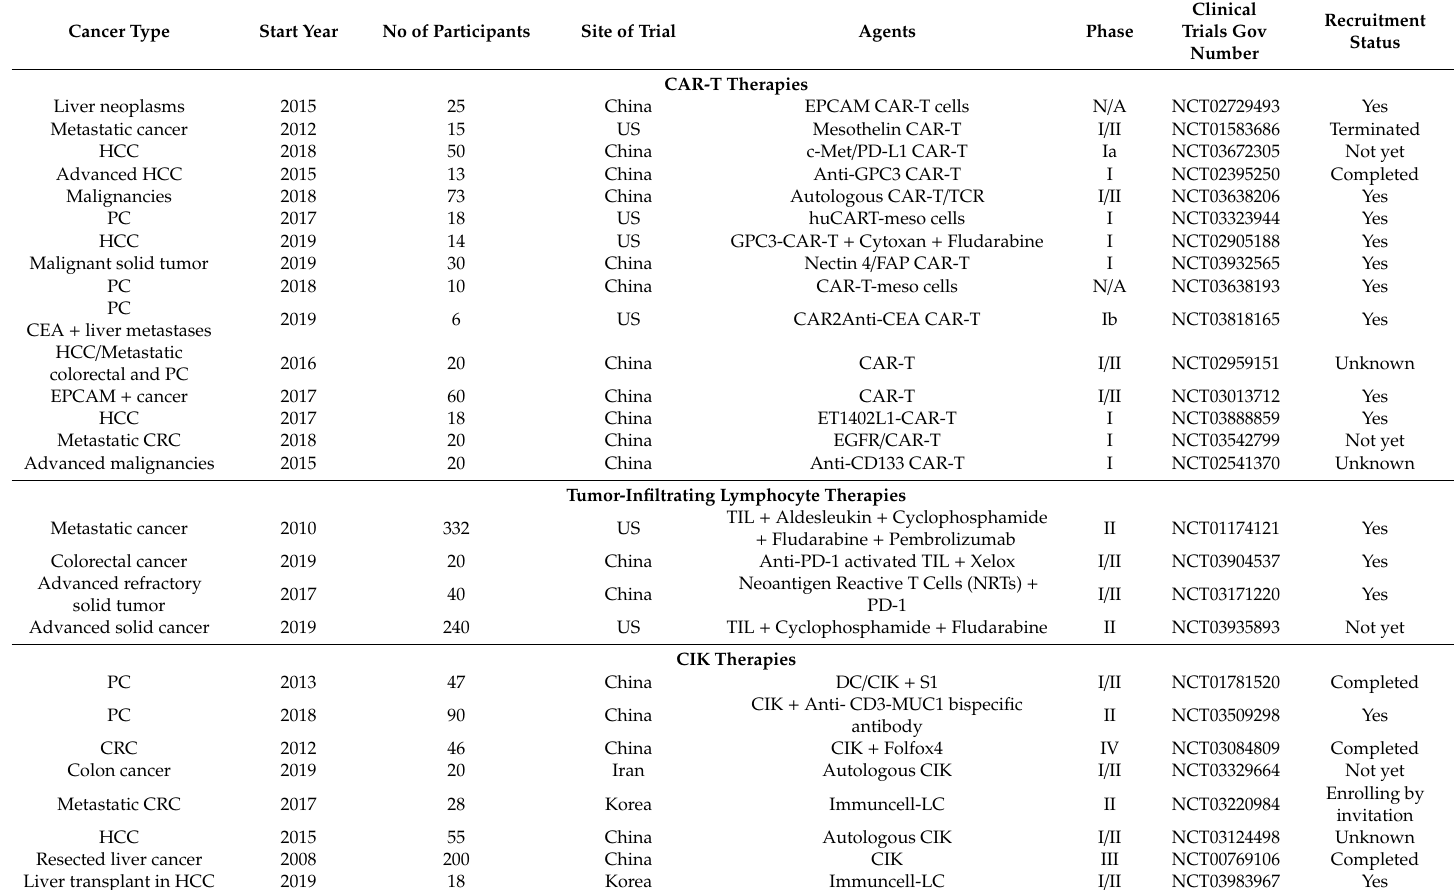
Table 1. Clinical trials of various adoptive immunotherapies in gastrointestinal (GI)